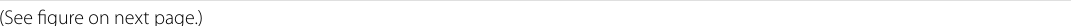
figure on next Fig. 4 Electrochemical performance of full-cell LIBs and SEM images of cycled Li metal anodes: long-term cycling stability at a , c 1 C and b 2 C; d galvanostatic charge–discharge profiles at 1st, 100th, 150th and 200th cycle; SEM images of e , f bare Li and g , h PAF-protected Li foils after 200 charge/discharge